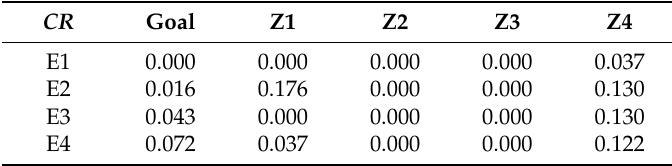
Table 6. CR values of main criteria and sub-criteria comparative